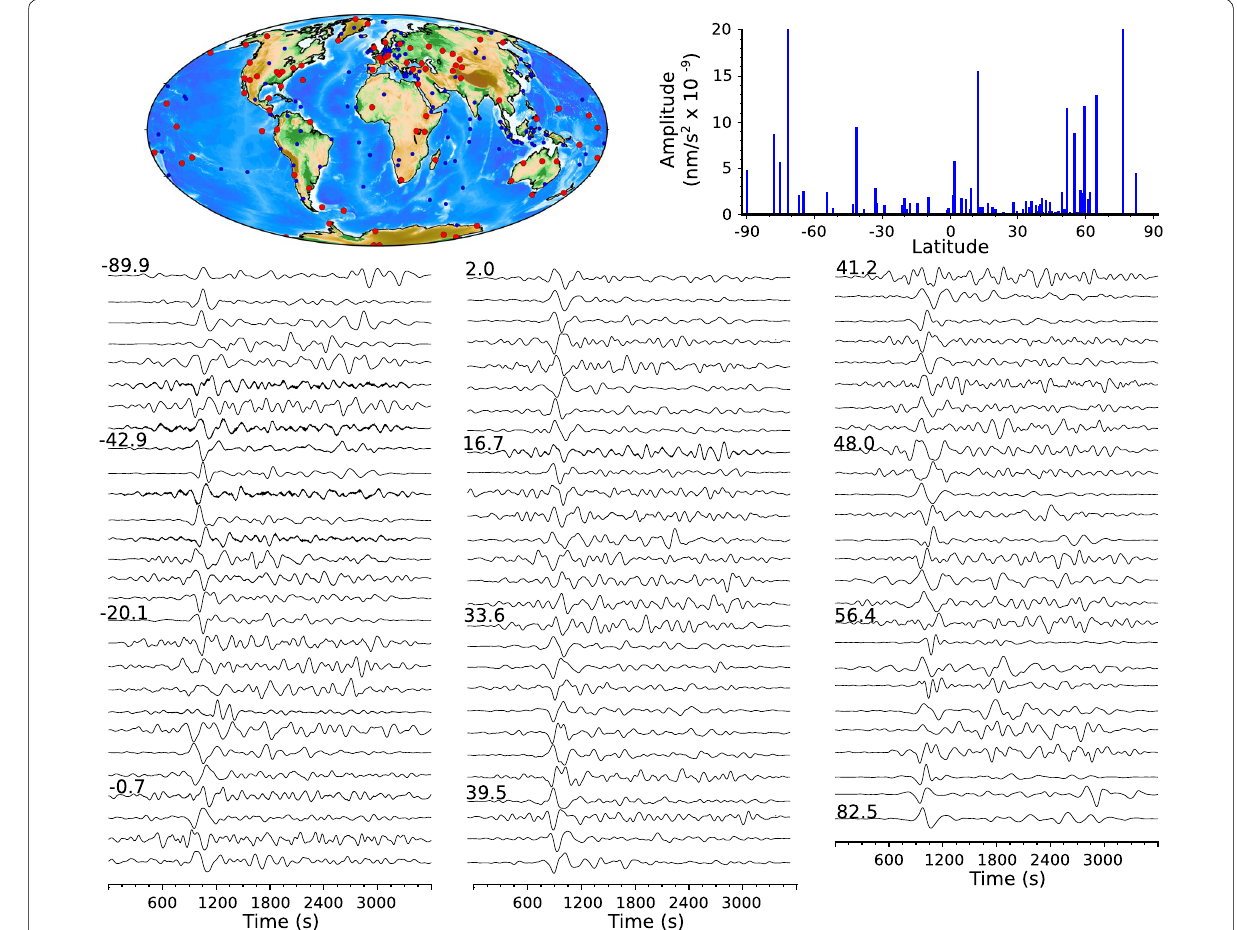
Fig. 1 Seismograms during the 2017/09/07 SSC event. Seismograms show 1 h of the vertical seismic acceleration, as recorded by the 82 broad-band stations distributed worldwide with positive identifications. The traces are normalized in amplitude after low-pass filtering at 0.01 Hz and ordered by latitude (labels show reference latitudes). The upper left panel map shows with red dots the sites with clear seismic recording of the SSC event and with black dots, the stations without clear evidences. Upper right panel shows the peak amplitude of the seismic signals as a function of